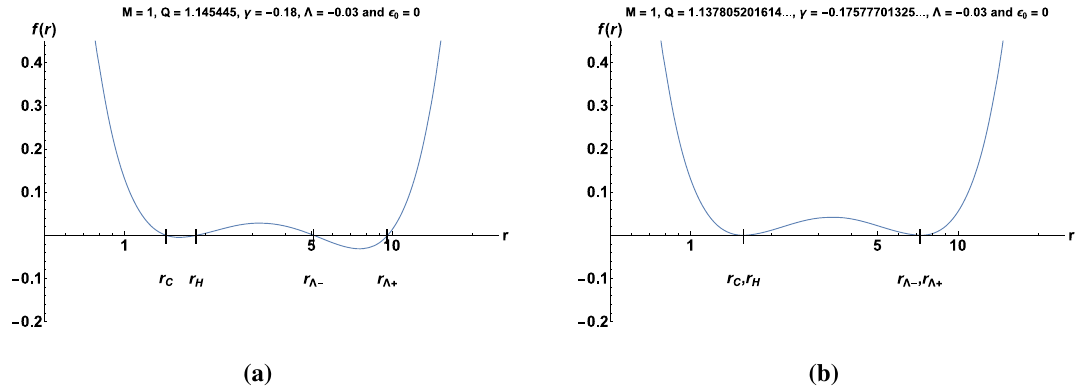
Fig. 3 Parameter spaces of black holes with M = 1 ,(cid:5) 0 = 0 and (cid:6) = − 0 . 03. (Left) parameter space of black holes with two horizons, r (cid:6) − and r (cid:6) + and “Naked-AdS” refers to a region where f ( r ) has no real roots. (Center) parameter space of the black holes with a smaller